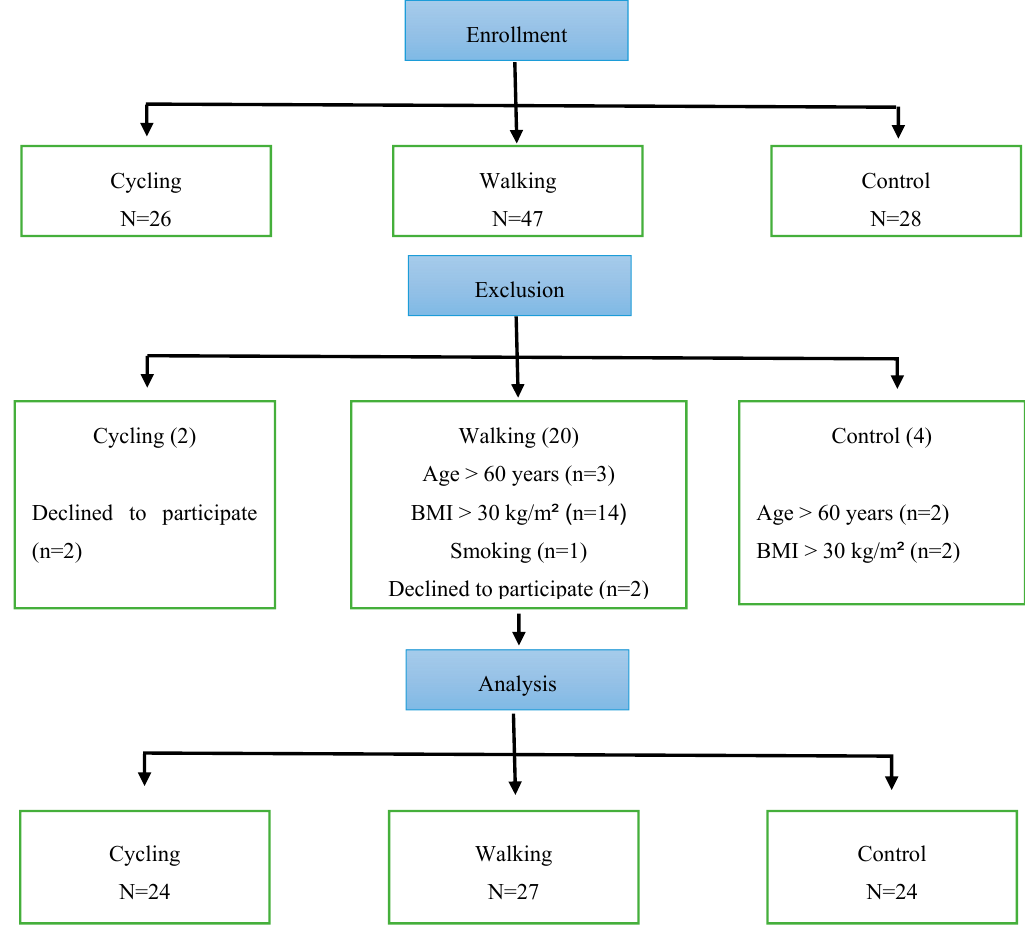
Figure 1. Flowchart of participants’ recruitment and exclusion